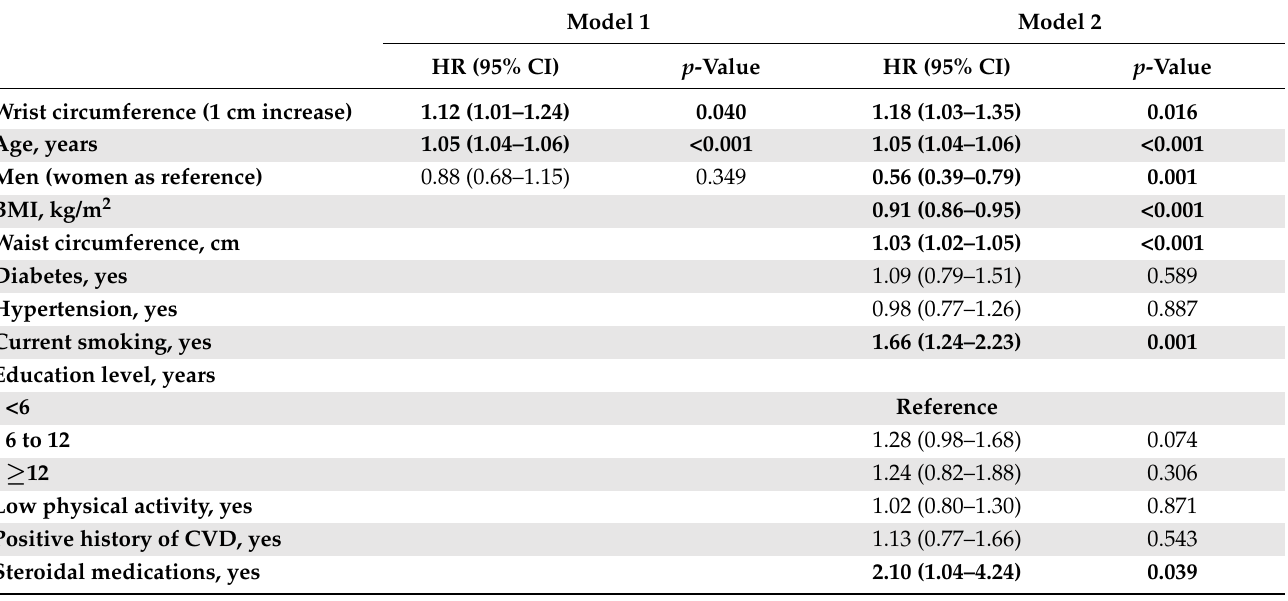
activity, positive history of CVD, and use of steroidal